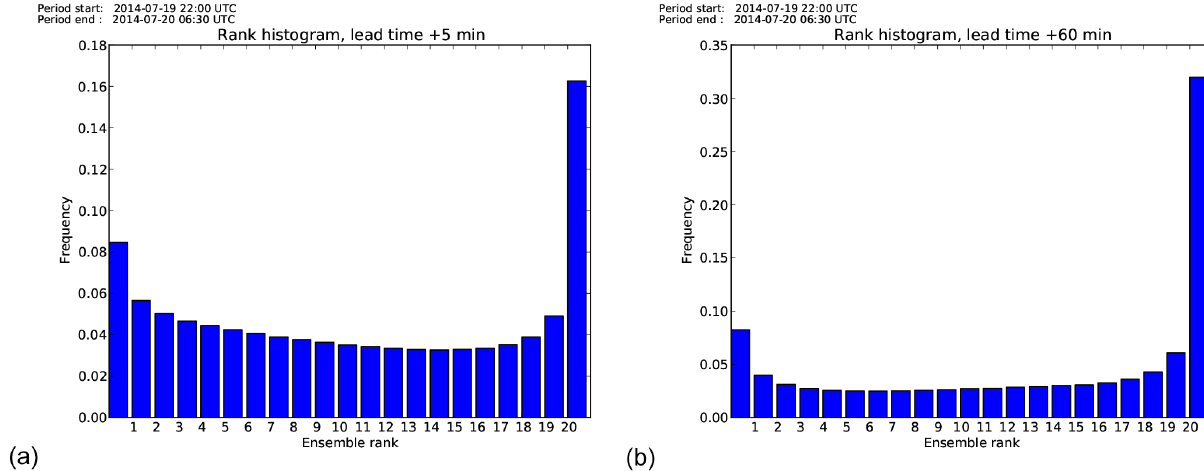
Figure 10. Rank histograms for the Leuven case on 19–20 July 2014 for a lead time of (a) 5min and (b)